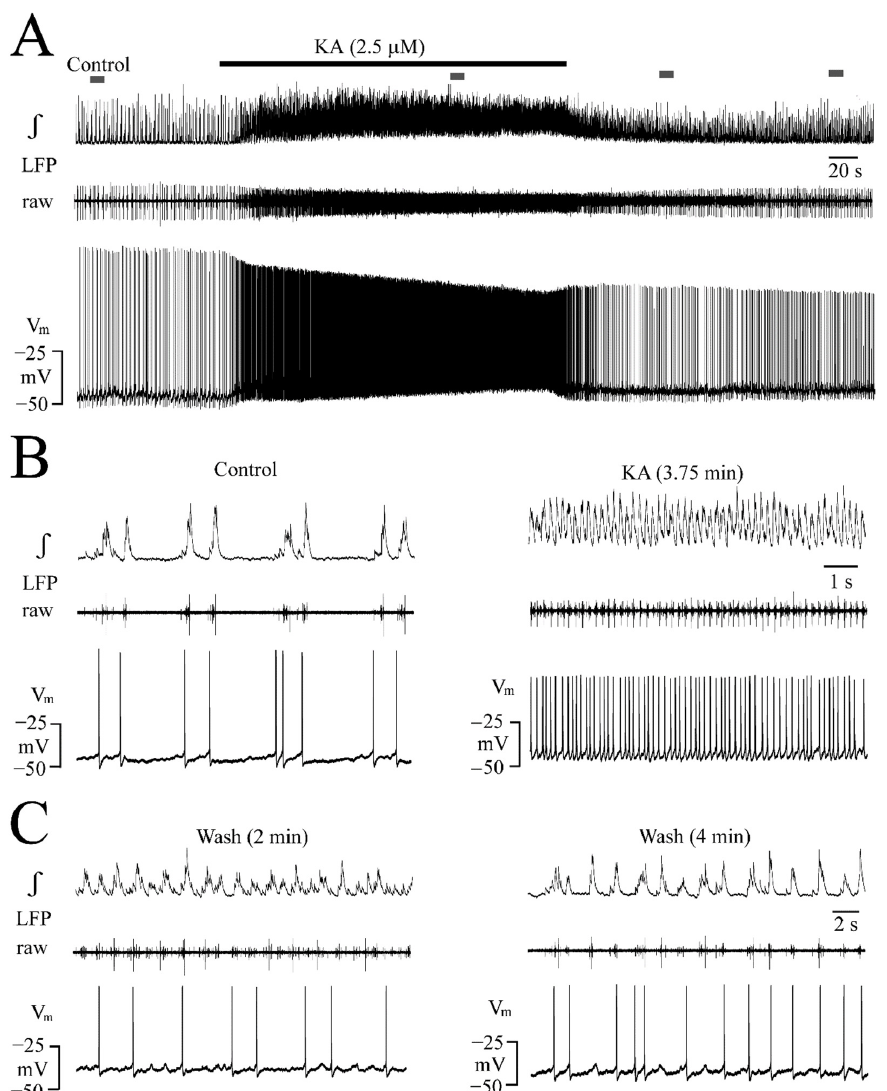
Figure 7. Effects of KA on LFP and neuronal V m . ( A ) The continuous traces show that KA accelerated both the LFP (with concomitant pattern transformation) and neuronal spiking in association with a depolarization of ~5 mV. ( B , C ) The traces on an expanded time scale that were taken at the time periods indicated by the grey boxes in ( A ) show the KA effects in more detail.